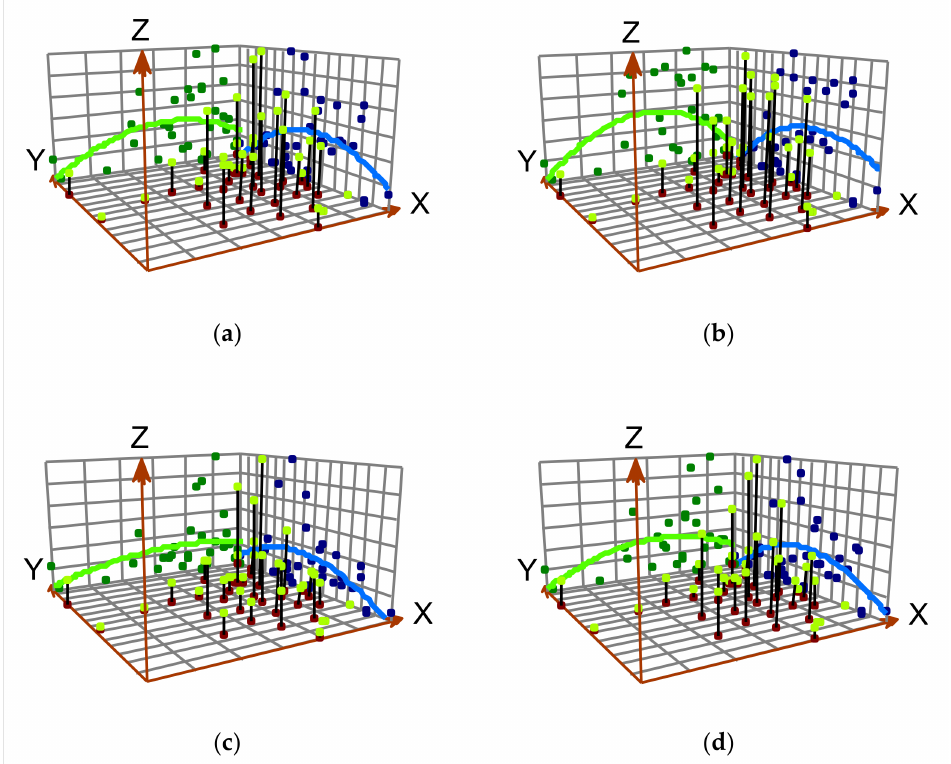
Figure 3. Spatial trend map of vegetable-sown area and yield in China. ( a ) 2010 vegetable-sown area;